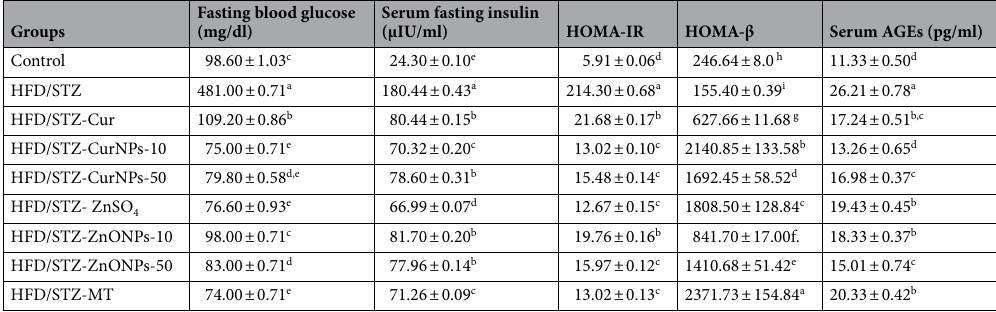
Table 2. Effect of CurNPs and ZnONPs administration on fasting blood glucose, serum fasting insulin, HOMA-IR, HOMA-β, and AGEs levels of HFD/STZ-induced diabetic and control rats. Values are expressed as mean ± SEM (n = 7), means for the same parameter with different letters in each column are significantly different (Tukey, p < 0.01).